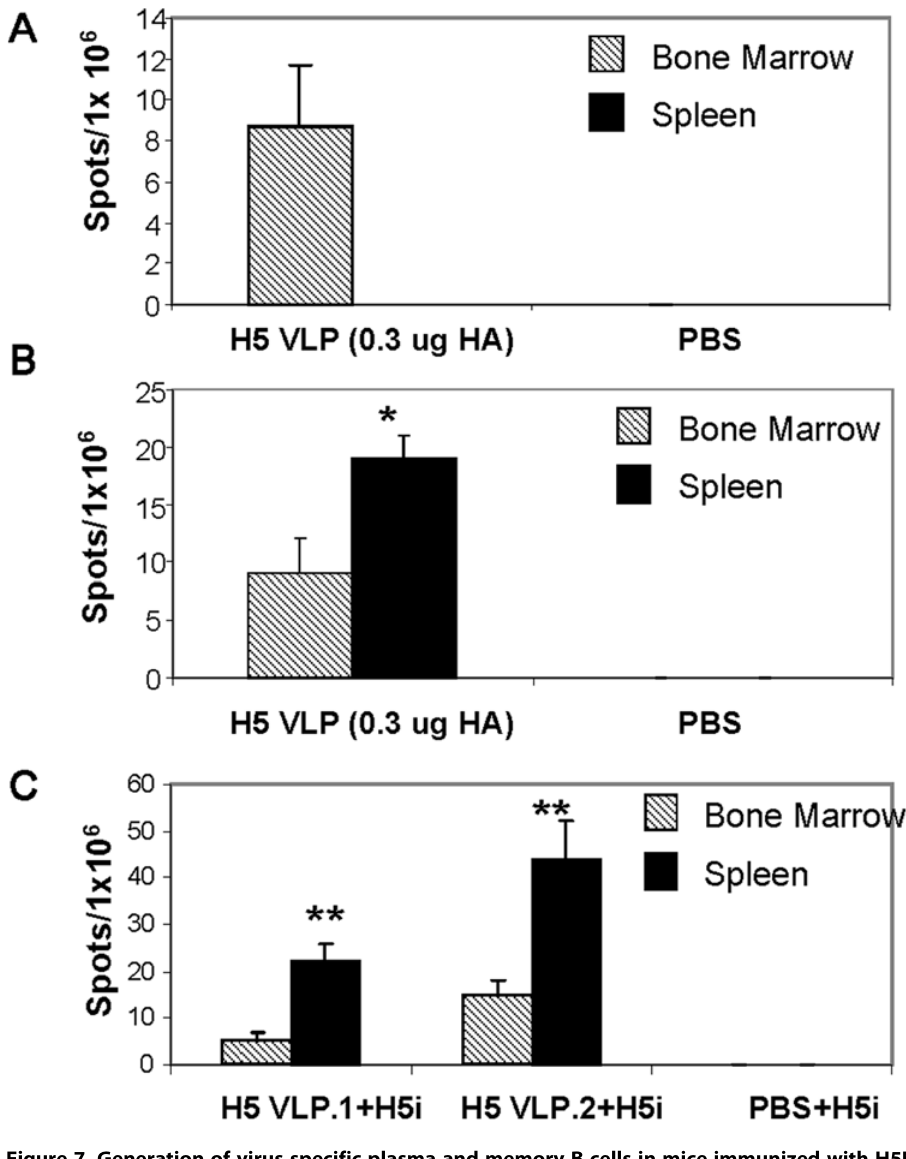
Figure 7. Generation of virus specific plasma and memory B cells in mice immunized with H5N1 VLPs. A) Generation of virus specific antibody secreting plasma cells. Groups of mice (n=6) were intranasally immunized with influenza H5N1 VLPs (containing 0.3 m g HA) or PBS buffer at weeks 0 and 4. At 4 weeks post immunization, bone marrow and spleen cells were prepared and in vitro cultured for 18 hrs on plates coated with inactivated rg D H5N1 virus to detect the antibody secreting cell spots. B) Antibody secreting cells after 3-day culture stimulation. The bone marrow and spleen cells were from the same group of mice as in A except the 3-day in vitro culture. C) Antibody secreting cells after 18 hrs culture. Groups of mice (n=6) were intranasally immunized once (H5 VLP.1 + H5i) or twice (H5 VLP.2 + H5i) (weeks 0 and 4) with influenza H5N1 VLPs (containing 0.3 m g HA) or PBS buffer (PBS + H5i) and were administered with inactivated rg D H5N1 virus (2.5 m g) 6 days earlier before euthanasia. *, ** indicate statistically significant differences between bone marrow and spleen (p , 0.05 and p , 0.01 respectively) as determined by Student’s 2-tailed